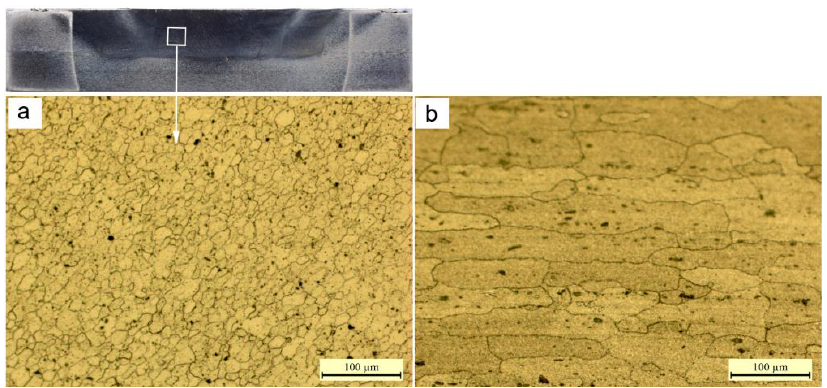
Figure 9. Optical microscope images showing the microstructures of ( a ) FSLW 2024 sample; ( b ) rolled 2024-O substrate. rolled 2024-O